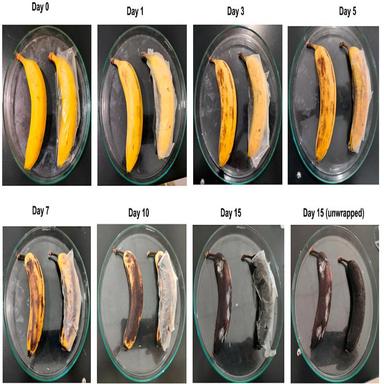
Monitoring shelf-life of bananas from Day 0–15: unpacked (on the left side of each petriplate) and packed in PVA-PEG-10%PNSL-5%L@CuONPs nanocomposite (on the right side of each petriplate).